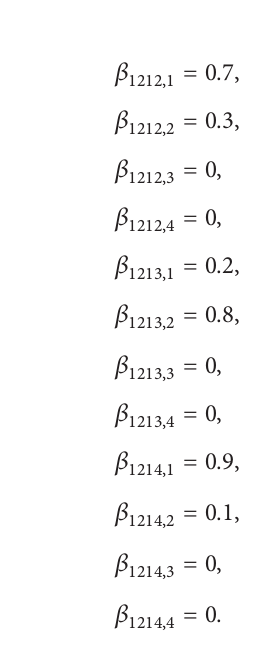
Figure 1: The architecture of the cloud